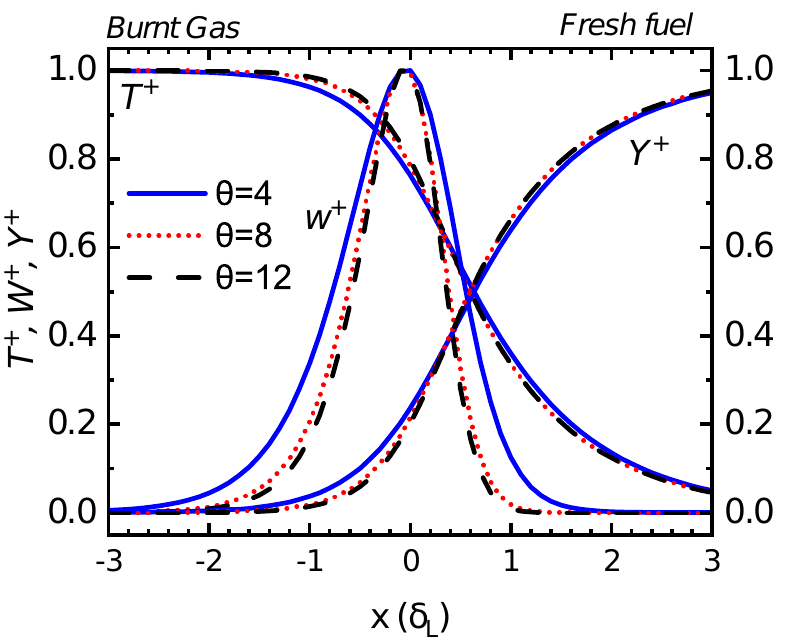
Figure 3. Influence of the thermal gas expansion on the flame structure. Shown is the variation of the normalized temperature T + , fuel mass fraction Y + , and reaction rate w + with the vertical distance y for different thermal expansion coefficients θ = 4,8, and 12, for the freely propagating planar